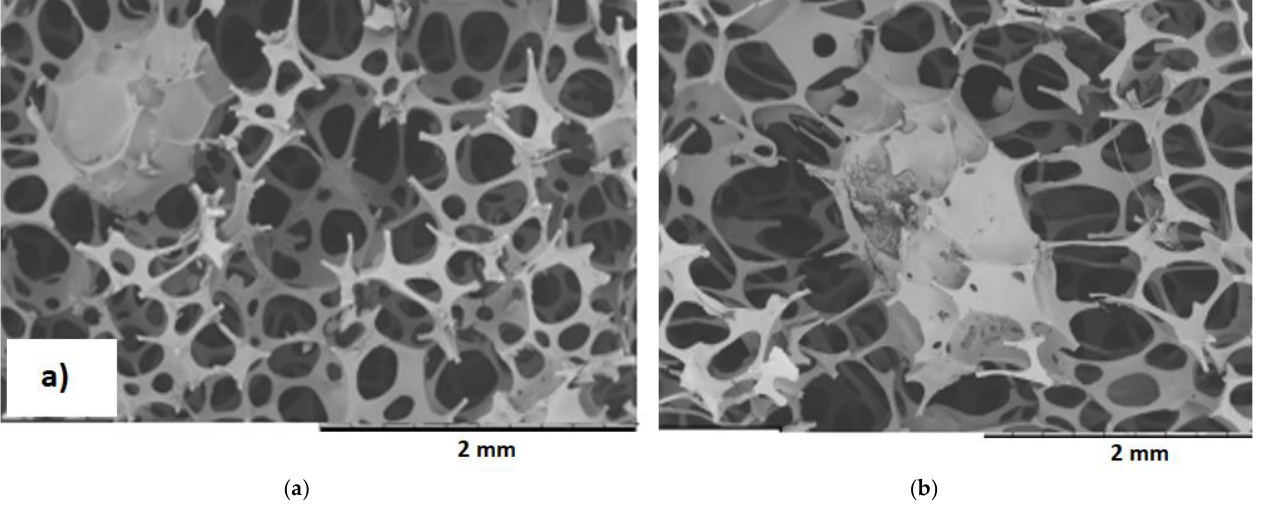
Figure 9. SEM images of ( a ) VEPUR 10 and ( b ) VEPUR 60.